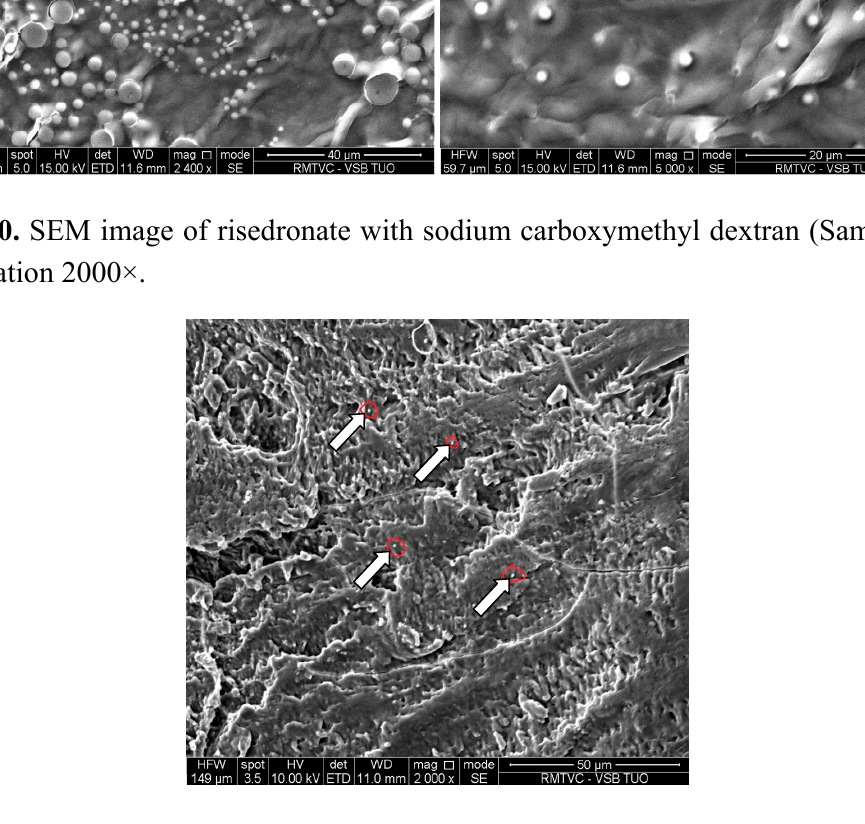
Figure 11. SEM image of risedronate with sodium dodecyl sulphate/macrogol 6000 (Sample 6c ) at magnification 800× ( A ) and 1600× ( B ).